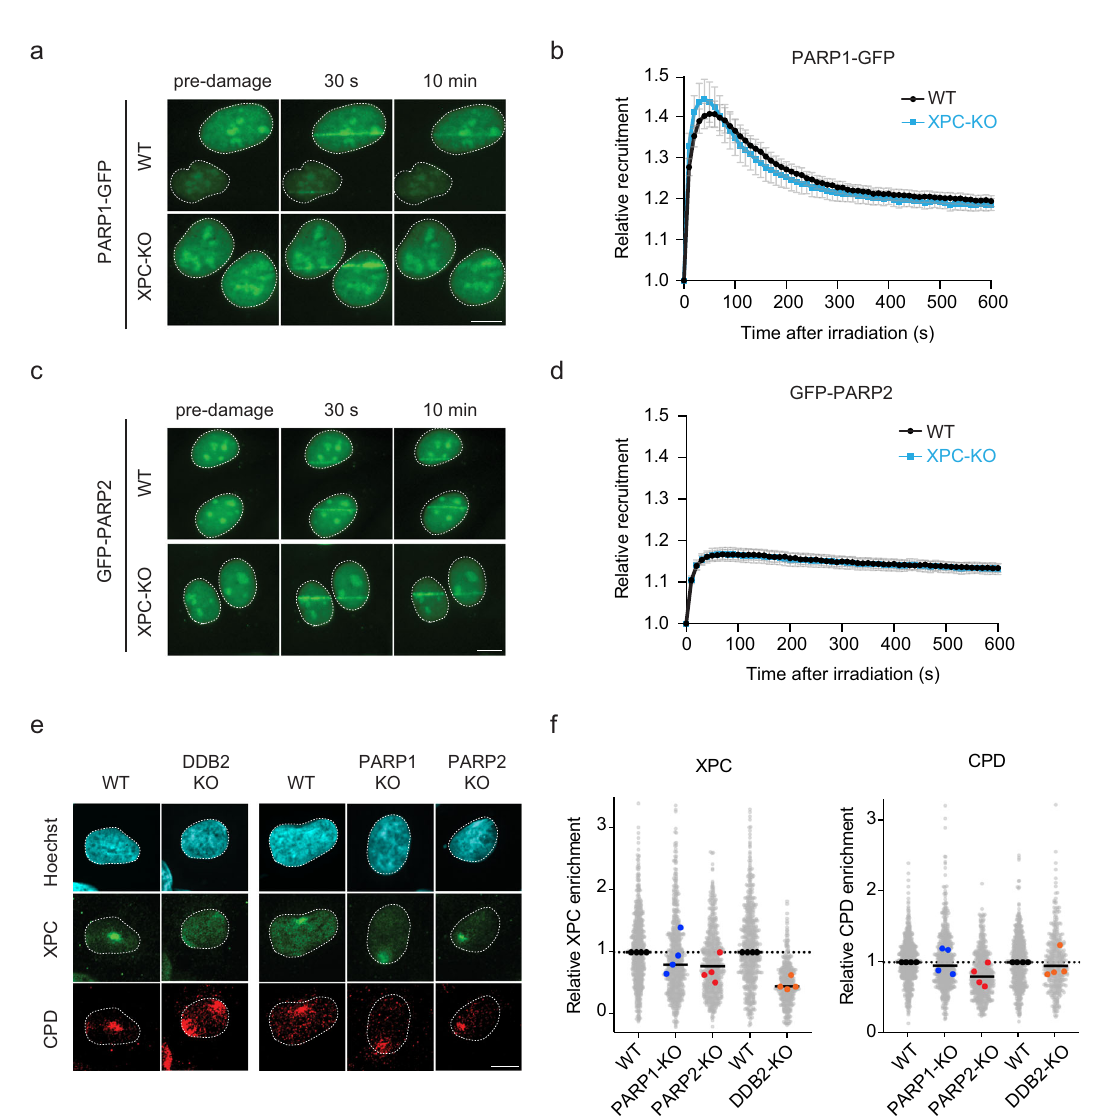
Fig. 3 PARP1/2 recruitment to UV lesions is independent of XPC. a , c Representative images of a PARP1-GFP and c GFP-PARP2 association with sites of local UV-C laser irradiation in U2OS (FRT) WT and XPC-KO cells at 30 sec and 10 min post-irradiation. b , d Kinetics of the recruitment of b PARP1-GFP and d GFP-PARP2 to and dissociation from UV-C lesions measured over 10 min in U2OS (FRT) WT and XPC-KO cells; 70 – 91 nuclei were analyzed in three independent biological replicates. The data are shown as mean + SEM normalized to pre-damage GFP intensity at micro-irradiation sites. e Representative images and f quanti fi cation of XPC colocalization with local UV-C irradiation sites (100 J/m 2 ) marked by CPD, measured 10 min post-irradiation. In all, 58 – 230 cells were analyzed per condition. All cells are depicted as individual data points (gray). The medians of four biological replicates are depicted as colored points, while the bar represents the median of all data points. The scale bar in a , c , e is 5 µ PARP enzymes accumulate independently of XPC at sites of micropore fi lters (Fig. 3e, f). The impact of PARP enzymes was UV-induced DNA damage, which is in line with earlier fi ndings milder than KO of DDB2, which led to considerably reduced showing that PARP1 recruitment is similar between WT and XPC recruitment, as reported previously 16,20,39 . Our data thus XPC-de fi cient cells at 10 min after UV irradiation 24 . suggest that XPC and PARP enzymes are recruited to DNA Deletion of either PARP1 or PARP2 had a minor impact on lesions largely independently, although PARP enzymes may the recruitment of XPC to UV lesions, as measured by stimulate XPC recruitment under certain conditions, such as low immuno fl uorescence after local UV irradiation through doses of DNA damage 20,24 .